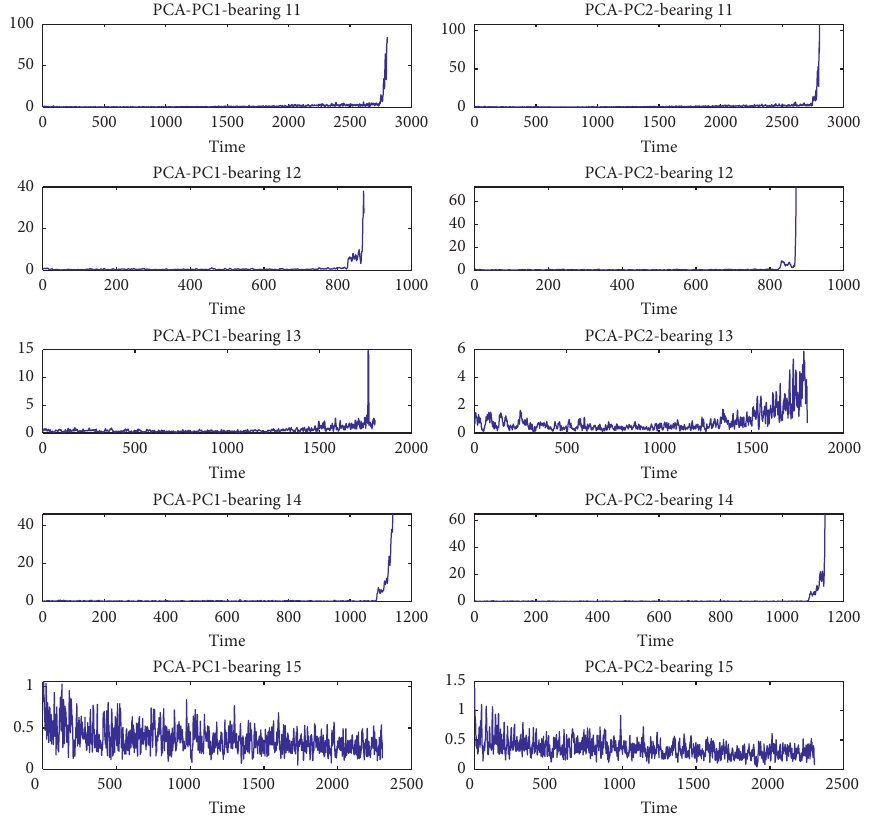
Figure 21: CVs for bearings 11–15 by using PCA under various conditions such as “Normal,” “Slight,” and